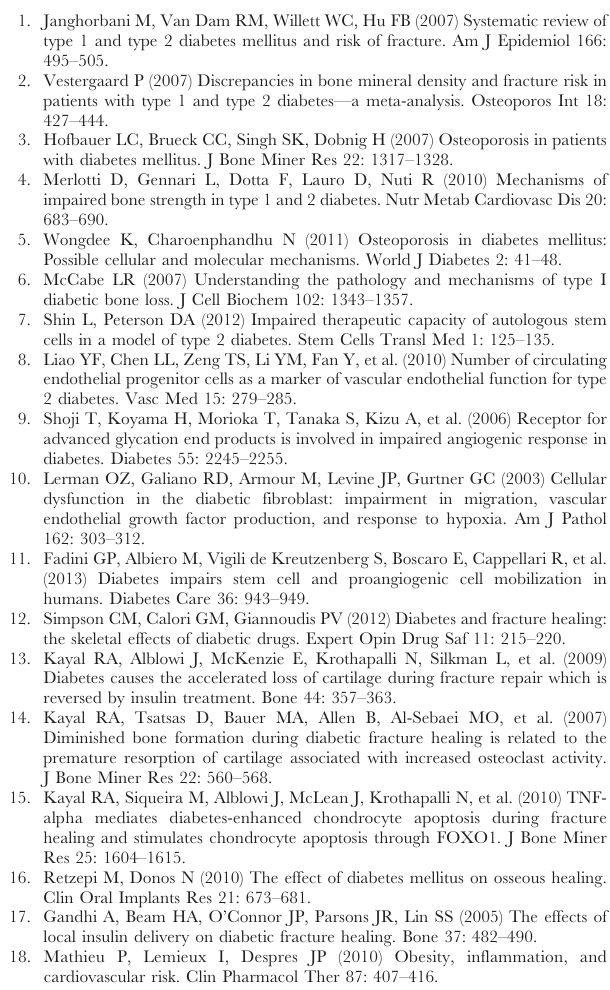
Table S1 Primers used for real-time PCR